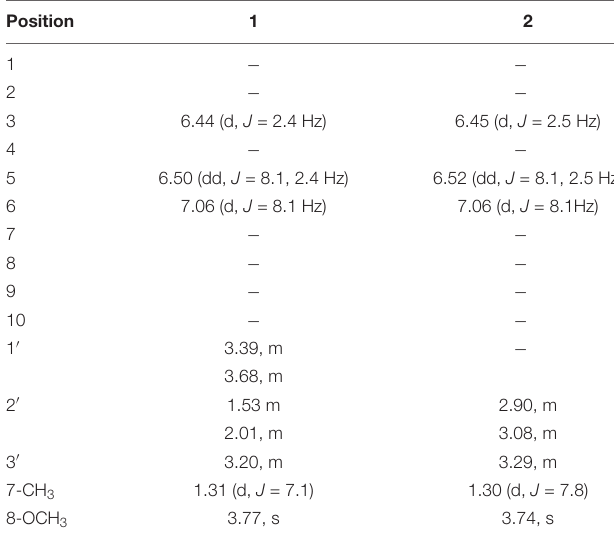
TABLE 1 | 1 H-NMR (CDCl 3 , 300 MHz) data of compounds [ 1 and 2 ] in ppm, J in Hz. Position